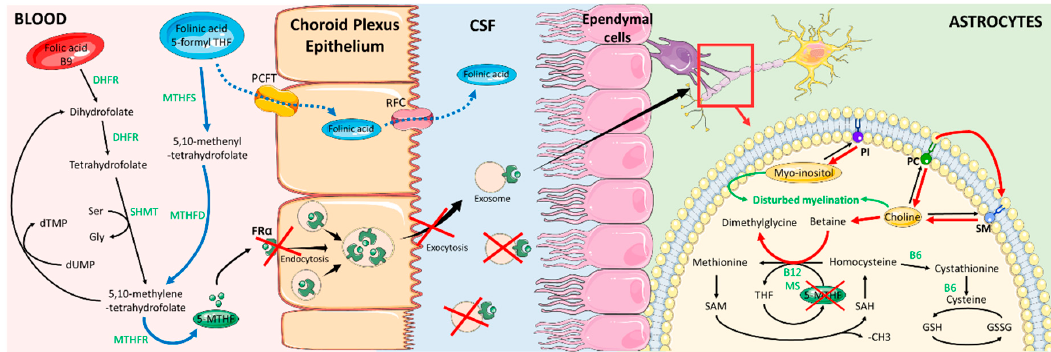
Figure 1. Folic acid metabolism and 5-MTHF transport across the choroid plexus epithelium in the brain. Red arrows and red crosses indicate the alternative pathway induced by FR α deficiency. Blue arrows indicate e ff ects of folinic acid treatment. KEYS: 5-MTHF: 5-methylenetetrahydrofolate; B6: Vitamin